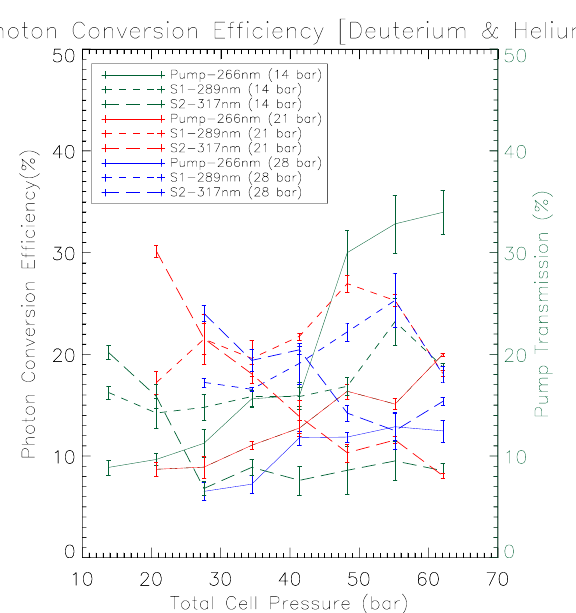
Figure 2a. Photon conversion efficiency of hydrogen as a function of total Raman cell pressure. The experiment was done with mul- tiple partial pressures of hydrogen and helium; the most efficient pressure combination of S1 was chosen for the GSFC TROPOZ DIAL. The pressures indicated in the legend are for the partial pres- sures of the Raman active gas. The uncertainty bars represent one standard deviation in the measurements.